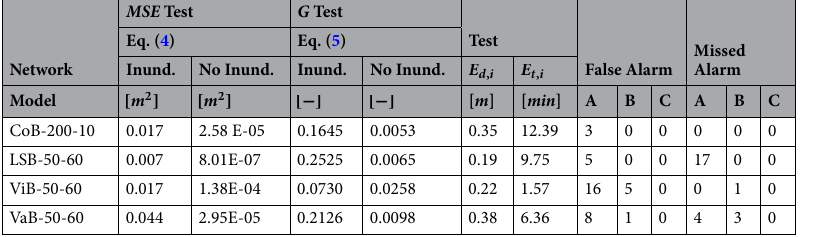
Table 5. Perfomance metrics test